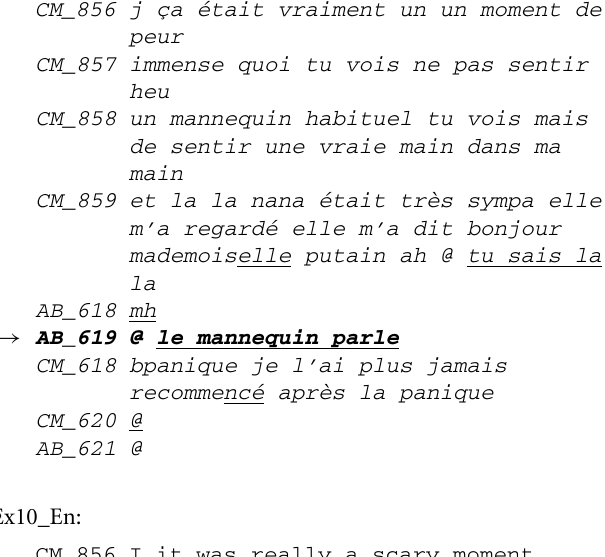
obvious at the gestural level (see Figure 1 ) where the behaviors are reversed: in Figure 1C , AB (left) looks away and produces a large illustrative gesture during her ERS, whereas CM (right) directs her gaze at AB and stops moving. This results in a local convergence